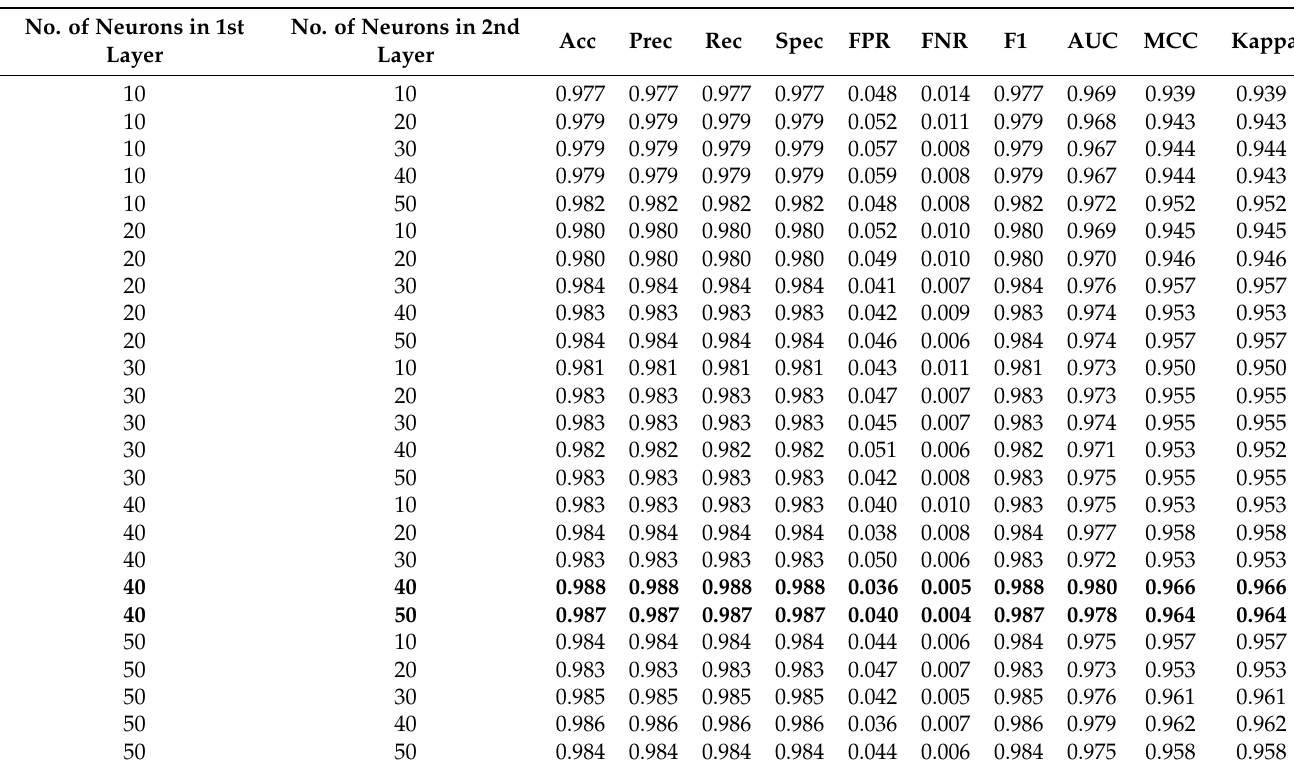
Table 5. Deep learning results with a different number of neurons in the hidden layers of the Dense-2 model. Best results are given in bold.